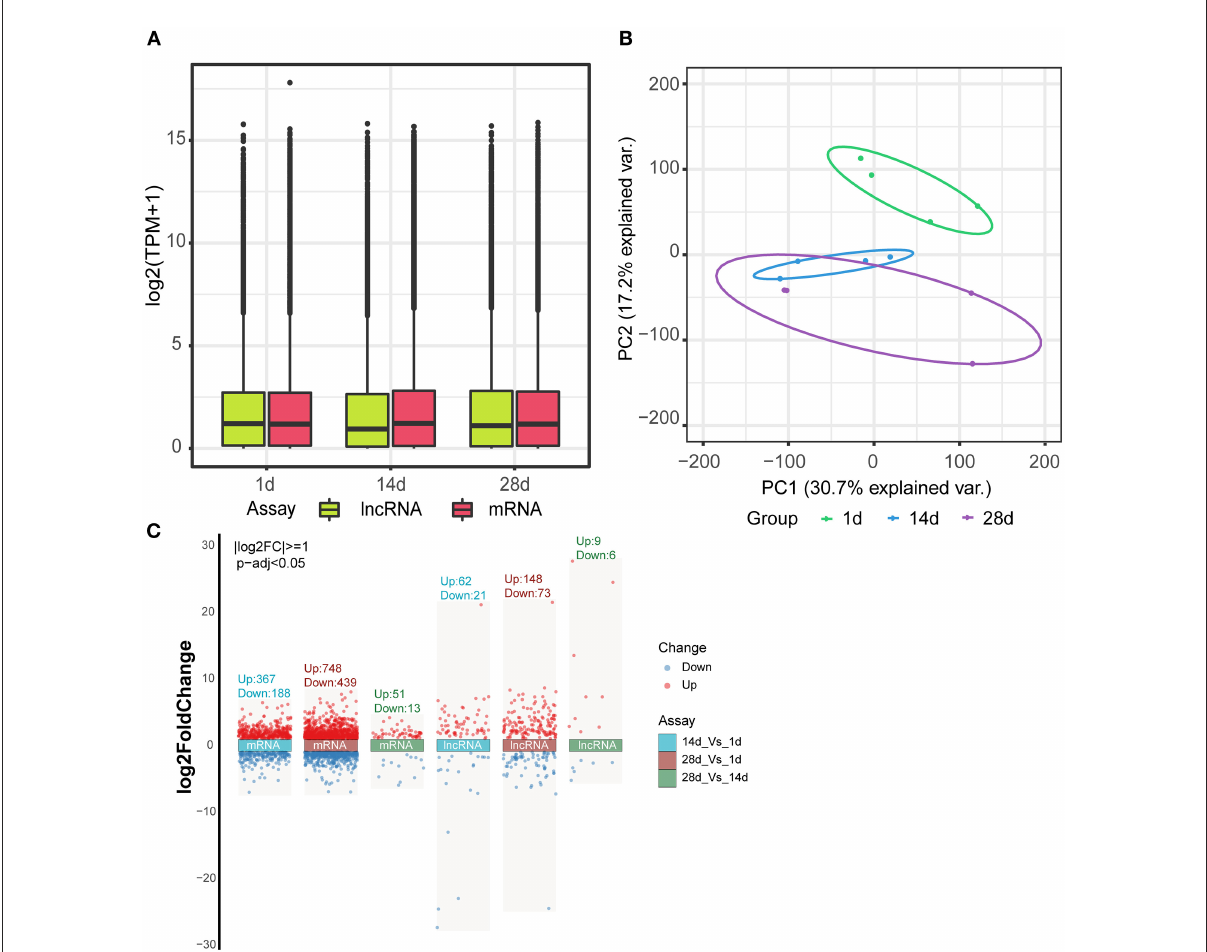
FIGURE3 Differential expression of mRNAs and lncRNAs. (A) Box line plot of mRNA and lncRNA expression in three different groups of spleen tissues. (B) Principal component analysis of mRNA and lncRNA in three different groups of spleen tissues. (C) Volcano plot analysis of mRNA and lncRNA expression between the three